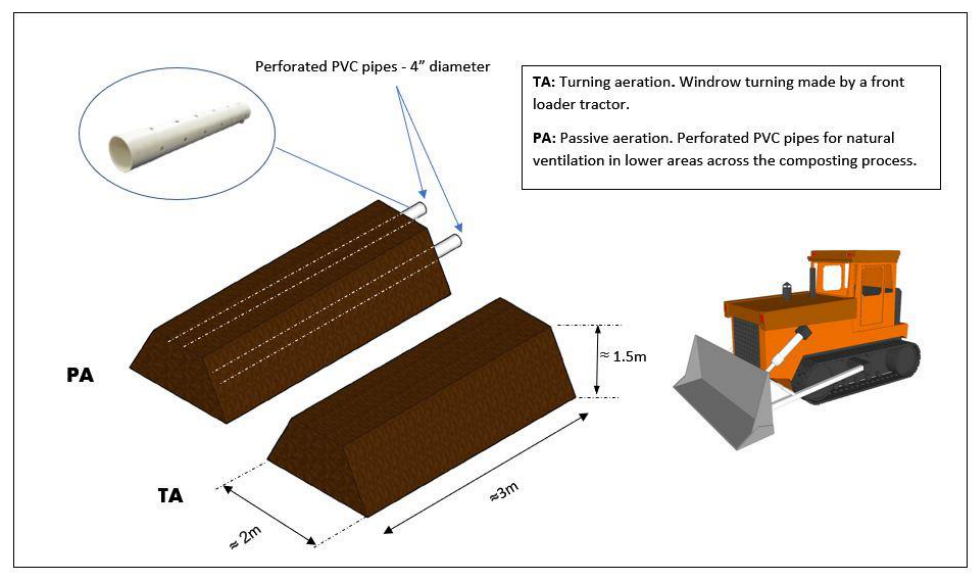
Figure 1. Graphical description of the set-up of co-composting experiment. PVC: polyvinylchlo- ride.